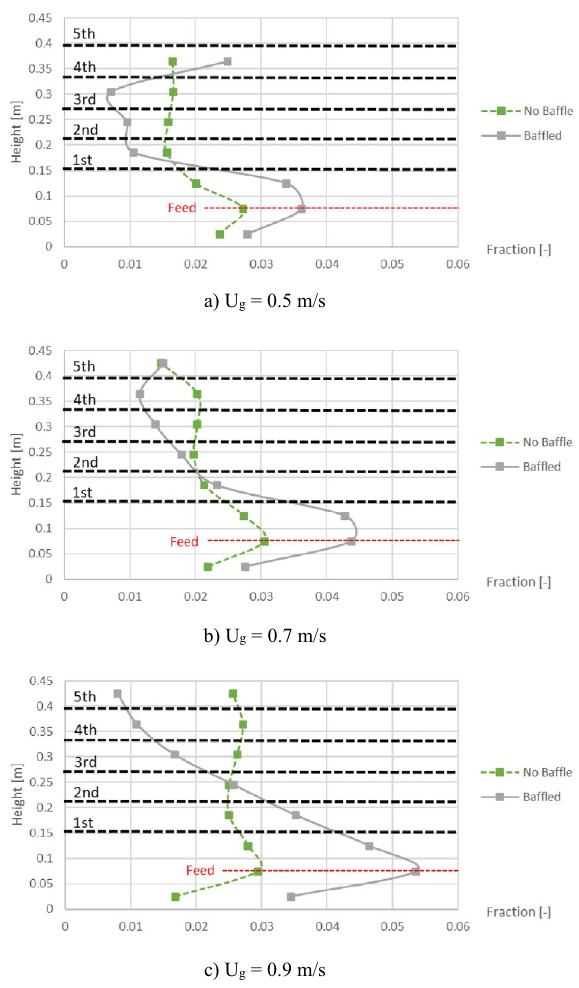
Figure 8. Time-and-area-averaged biomass fraction in bed before and after installing the baffles, when operating at various gas inlet